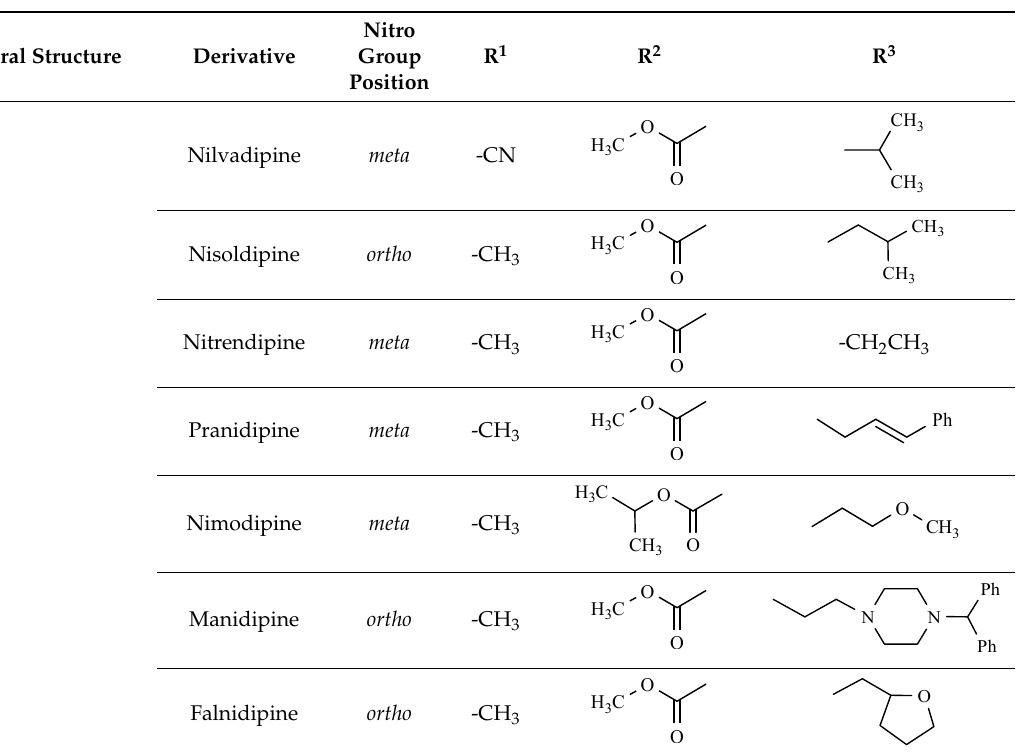
Table 1. Nifedipine derivatives.